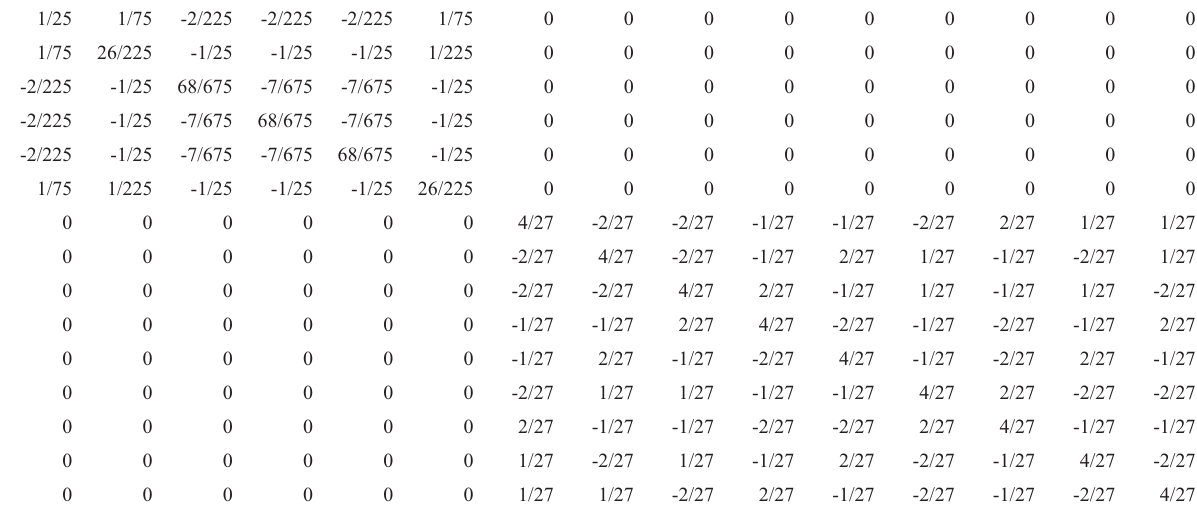
Table 10 - Estimates of the variances and covariances of the effects for an incomplete diallel model (Case 1, type 1 constraints) calculated using a matrix approach.